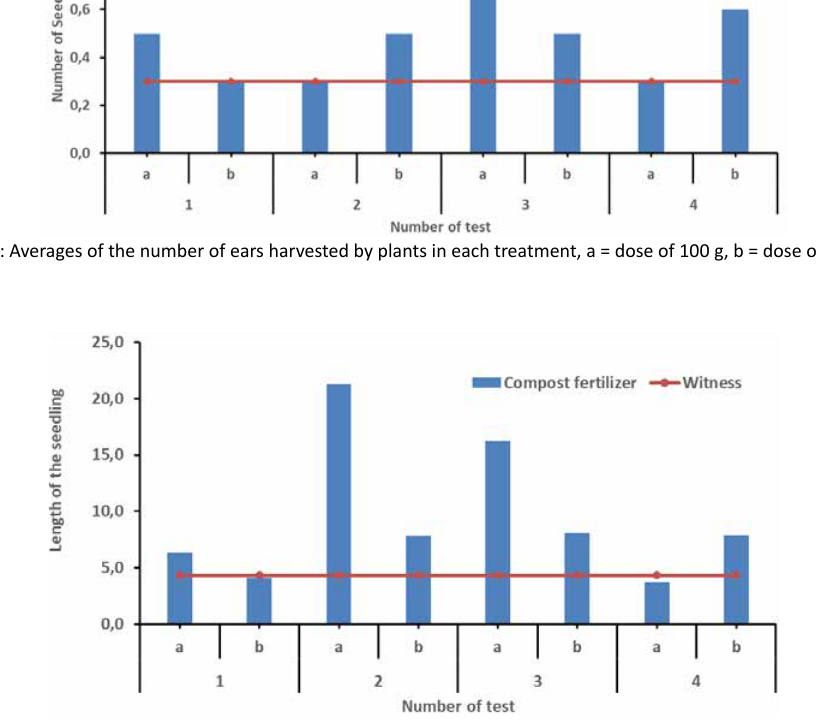
Fig. 5: Averages the length (cm) of the ears harvested in each treatment, a = dose of 100 g, b = dose of 200 g